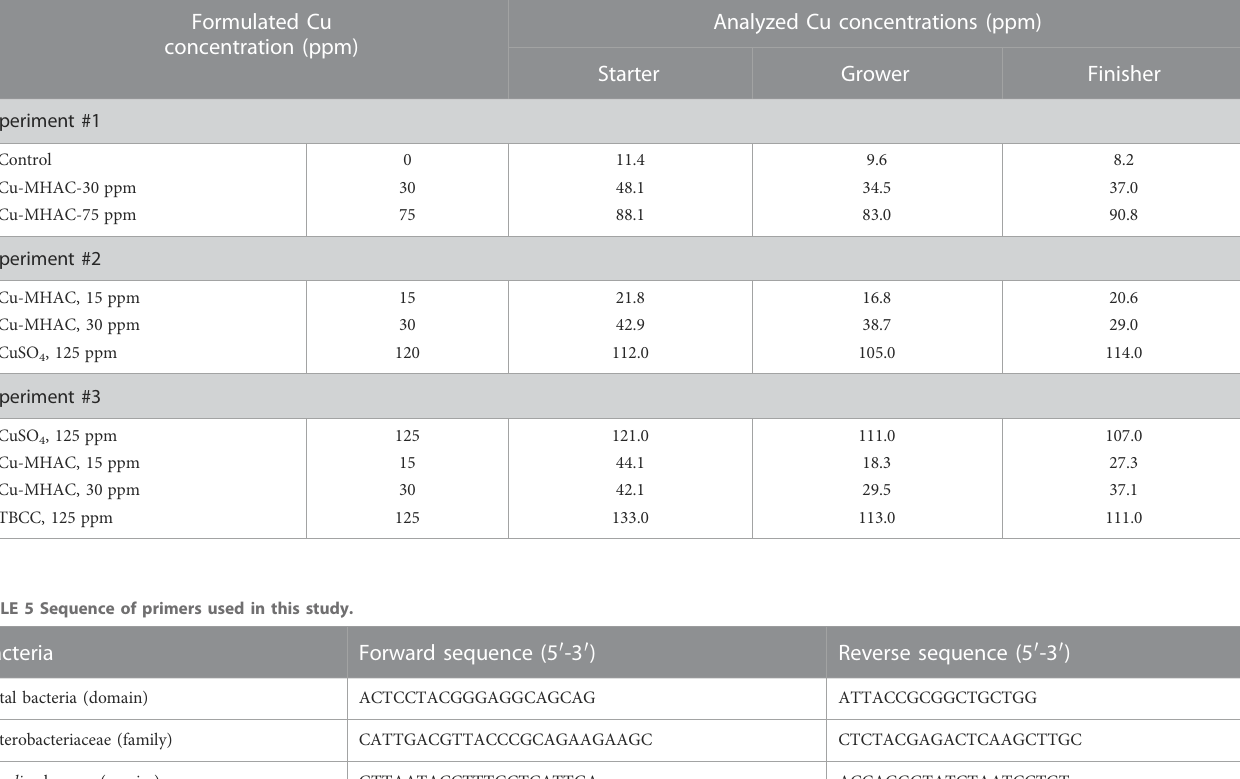
TABLE 4 Formulated and analyzed Cu concentrations in three experiments.